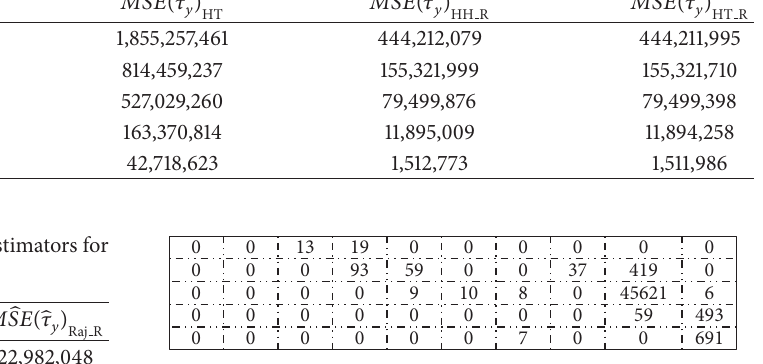
Figure 2: Simulated data ( 𝑥 -values) from the model 𝑥 𝑖 = 4𝑦 𝑖 − 𝜀 𝑖 .